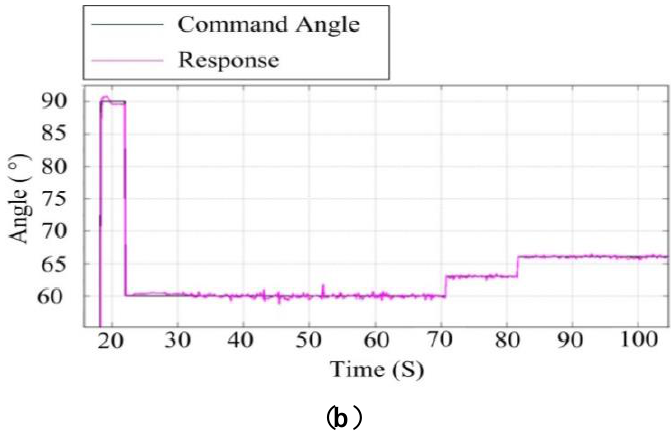
Figure 20. The tracking accuracy of the ISP in a real movable vehicle experiment: ( a ) the azimuth gimbal; ( b ) the pitch gimbal.